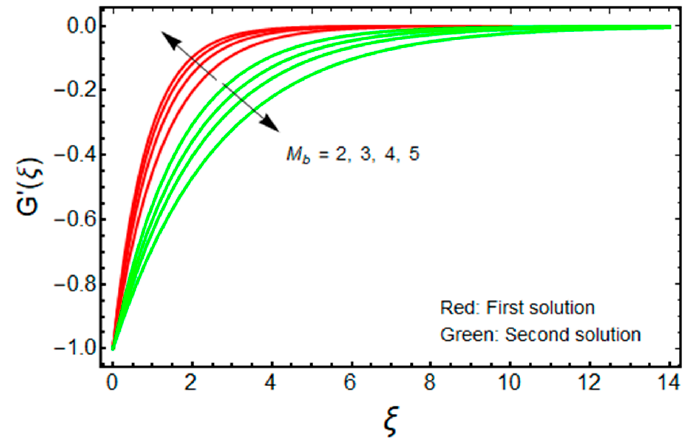
S on Figure 3. Effect of Figure 3. Effect of Figure 3. Effect of S b on θ ( ξ ) when φ = 0.025, χ = 1, M b = 0.5, R d = 1.5, m = 1. b Figure 3. Effect of